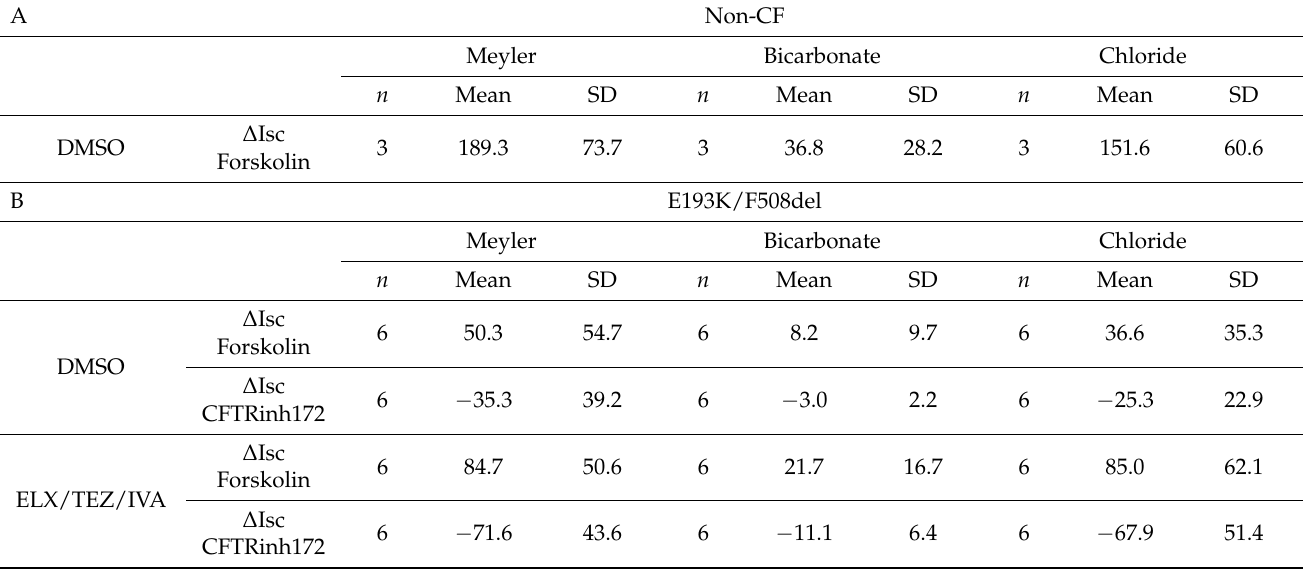
Table 1. Separate and combined measurements of chloride and bicarbonate secretory currents in epithelial monolayers (2D HIOs). Peak forskolin-induced and CFTRinh172-inhibited Isc re- sponses in Meyler, chloride only, or bicarbonate only bath fluid. A, non-CF individual; B, Patient 1 (E193K/F508del); C, Patient 2 (R334W/F508del); D, G542X/F508del. Mean ± SD of n technical replicates is